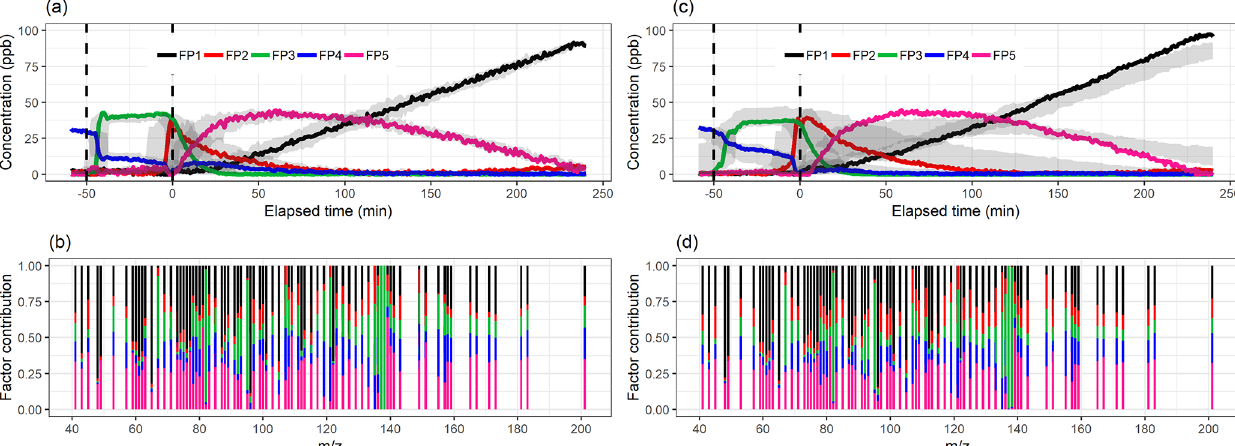
Figure 7. Factor time series and contribution from PMF with static error (a–b) and signal following error (c–d) for factorization rank 5. Shaded areas in the time series indicate the factor range for the bootstrap resamples; solid lines are for the measured gas-phase (PTR-MS) data. The colour code identifying the factors is the same in the top and bottom panels. Factors were identified as later-forming and slowly forming products (FP1), early products (FP2), α -pinene precursor (FP3), background or car exhaust precursor (FP4), and intermediate products (FP5).